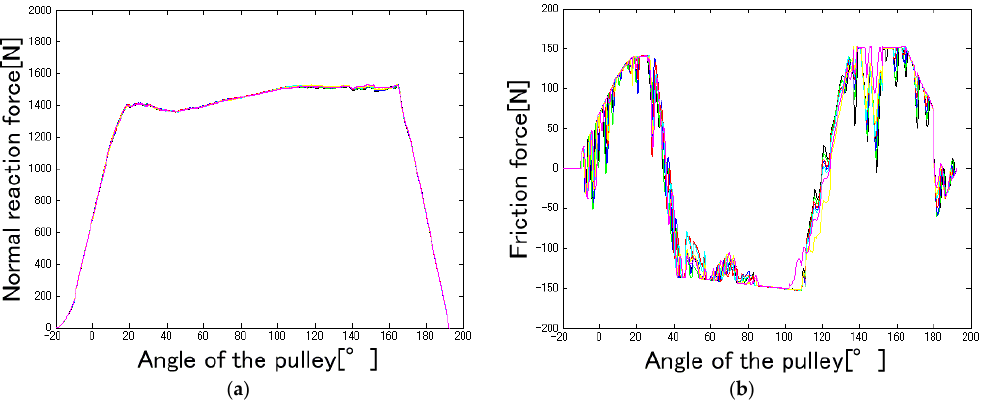
Figure 9. Normal contact and frictional force at each node of the element. ( a ) Normal contact force; ( b ) frictional force.